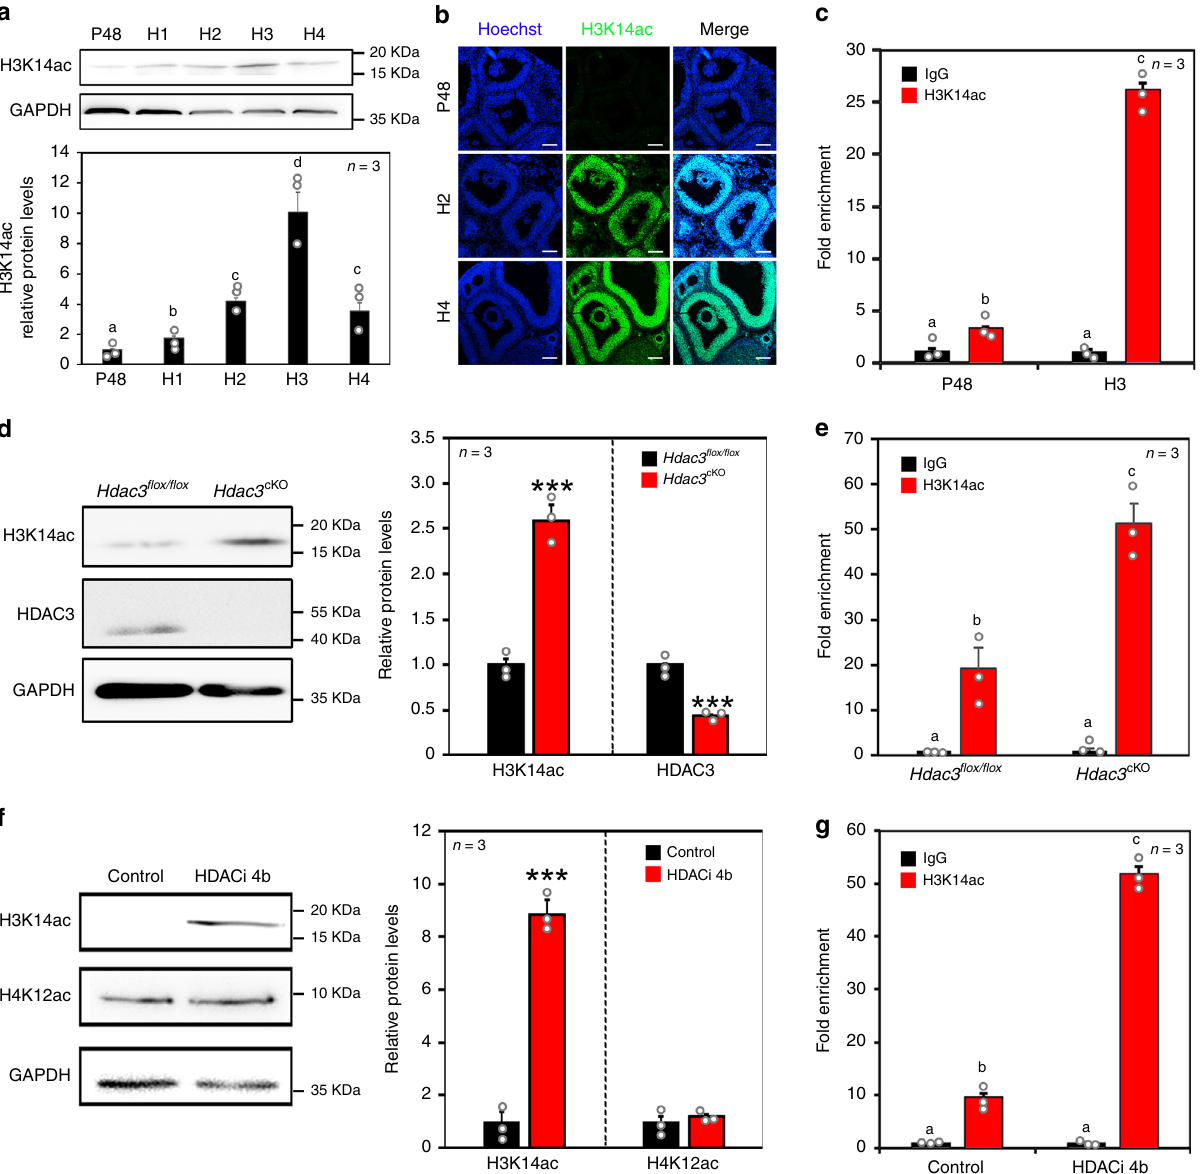
Fig. 3 H3K14ac mediated the effects of HDAC3 and LH on Areg expression. a H3K14ac levels were increased by hCG in a time-dependent manner. n = 3 biologically independent experiments. Data are presented as mean ± SEM, and different letters (a – d) indicate signi fi cant differences among groups (two- sided ANOVA and Holm – Š idák test), P (a, b)< 0.01, P (a, c) < 0.01, P (a, d) < 0.001, P (b, c) < 0.05, P (b, d) < 0.01, P (c, d) < 0.05. b Immunostaining revealed that LH increased H3K14ac (green) levels in GCs in vivo. Nuclei were dyed with Hoechst (blue). Scale bar = 100 µ m. n = 3